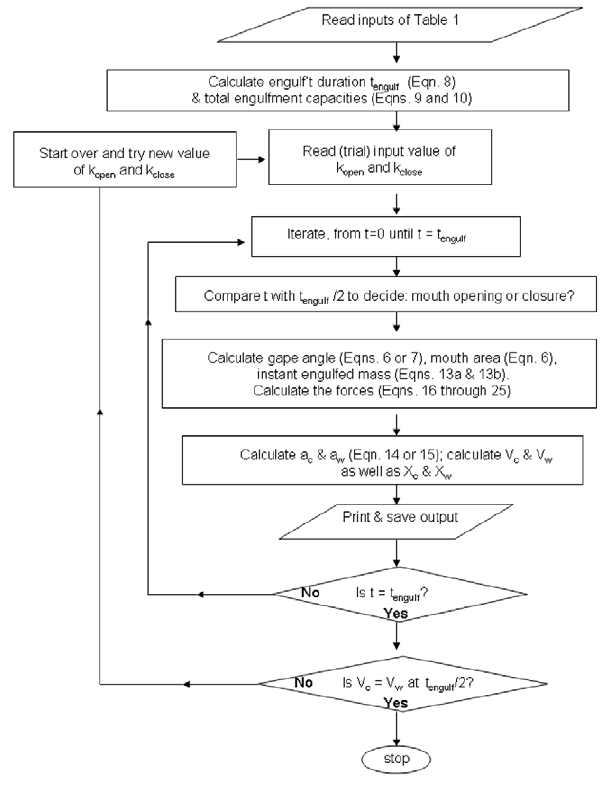
Figure 3. Logic flow diagram of the BLF model.